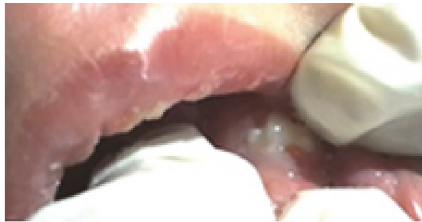
Figure 3: Newly erupted 74 numbered